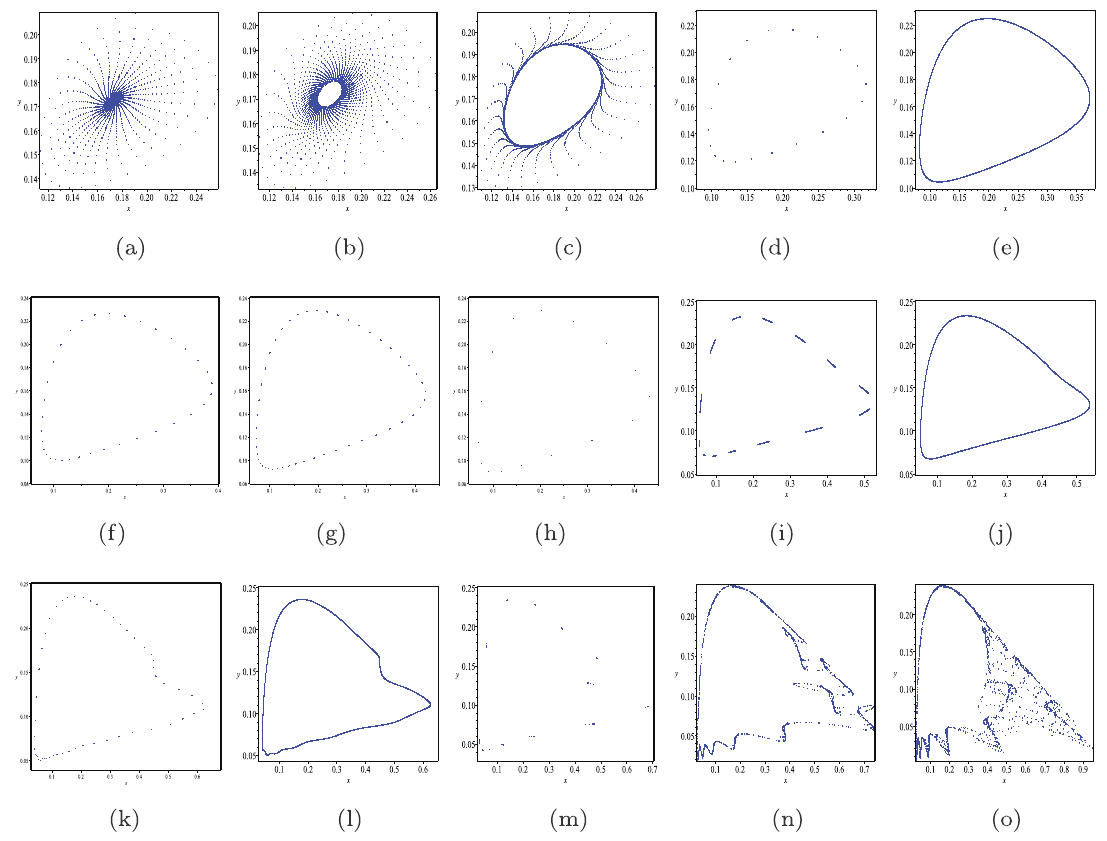
Figure 6: Phase portraits for various values of δ corresponding to Figure 5. ( a ) δ 1.24